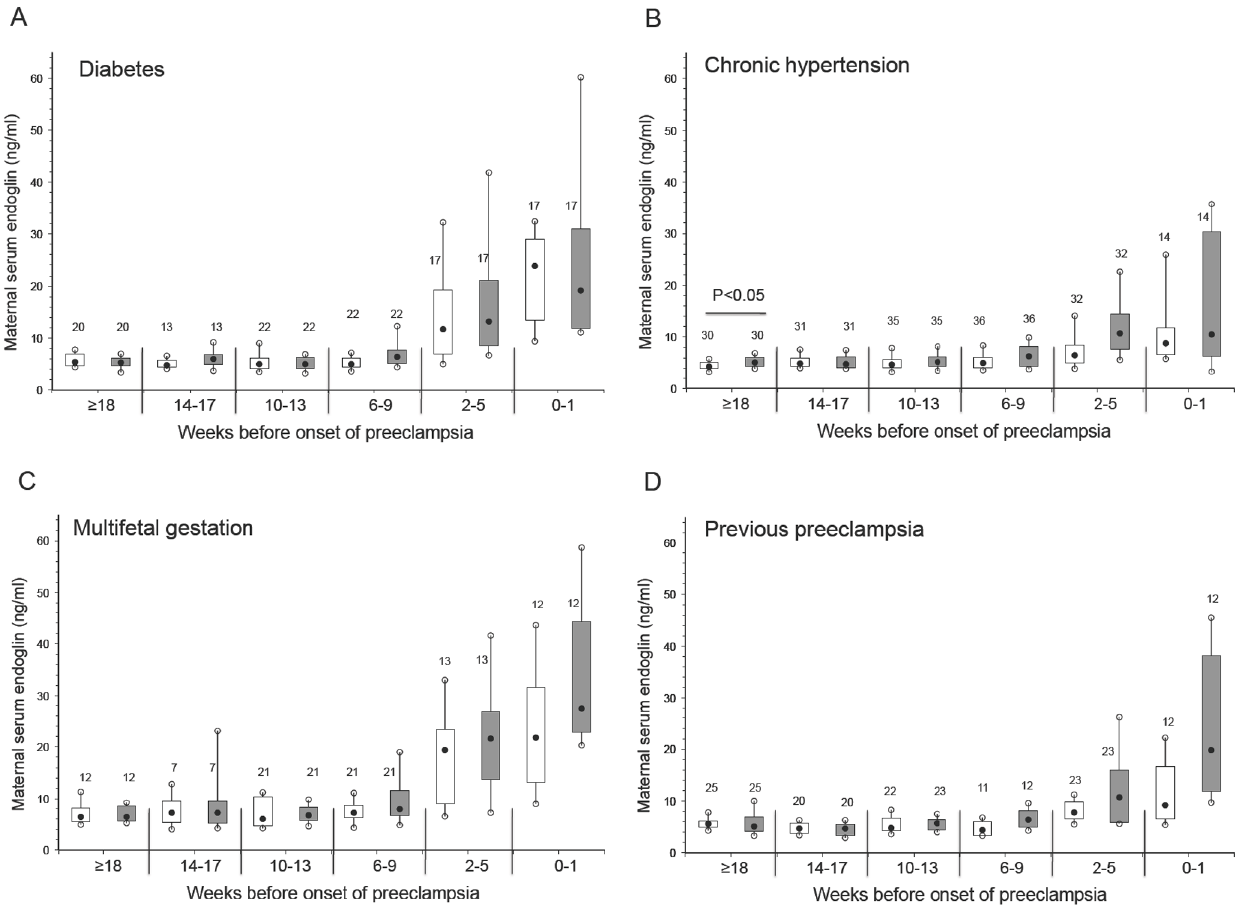
Figure 5. Maternal serum sEng by clinical onset of preeclampsia matched to control samples in women with pre-existing diabetes (A), chronic hypertension (B), multifetal gestation (C), and previous preeclampsia (D). Open boxes are controls and shaded boxes are subjects who developed preeclampsia. The number above each box indicates the number of samples. The filled black circles are the median, the open circles are the 90th and 10th percentiles, and the top and bottom lines of the box are the 75 th and 25 th percentiles of the data for each group. Statistical significance is indicated by p values.